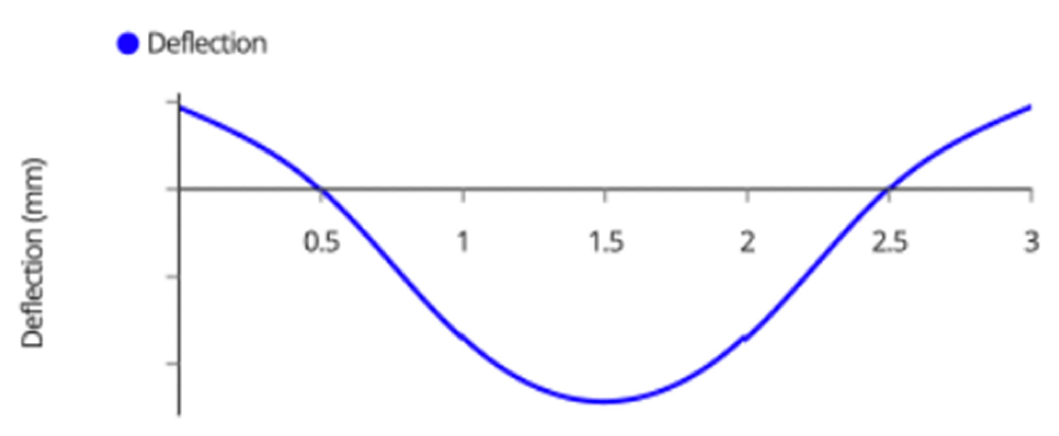
Figure A8. Beam Deflection Diagram.